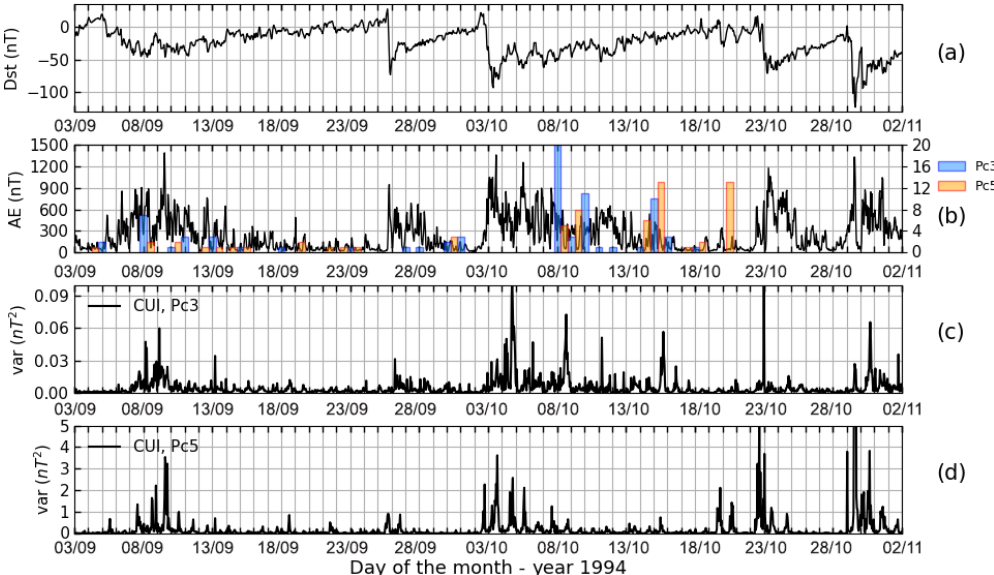
Figure 2. Geomagnetic indices and filtered ground geomagnetic pulsations during the period from 3 September to 1 November 1994. (a) Dst index; (b) AE index with the temporal location and number of events chosen for the pulsation analysis; (c) variance of Pc3 pulsations in the H component of the CUI station; (d) variance of Pc5 pulsations in the H component of the CUI station.